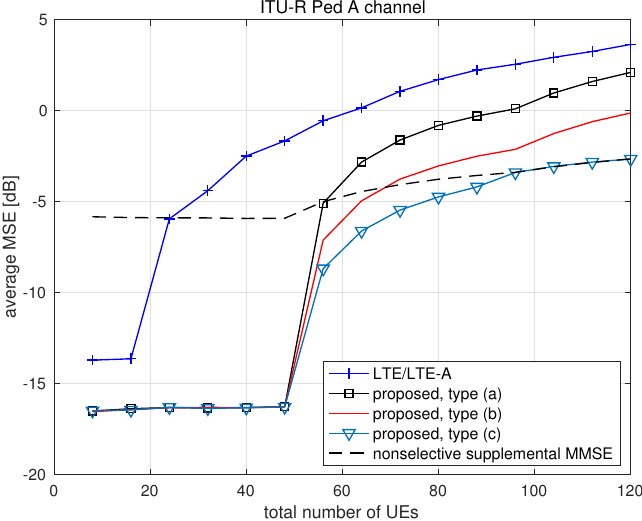
Figure 3. Average MSE of channel estimation with respect to the total number of UEs over block fading channel.